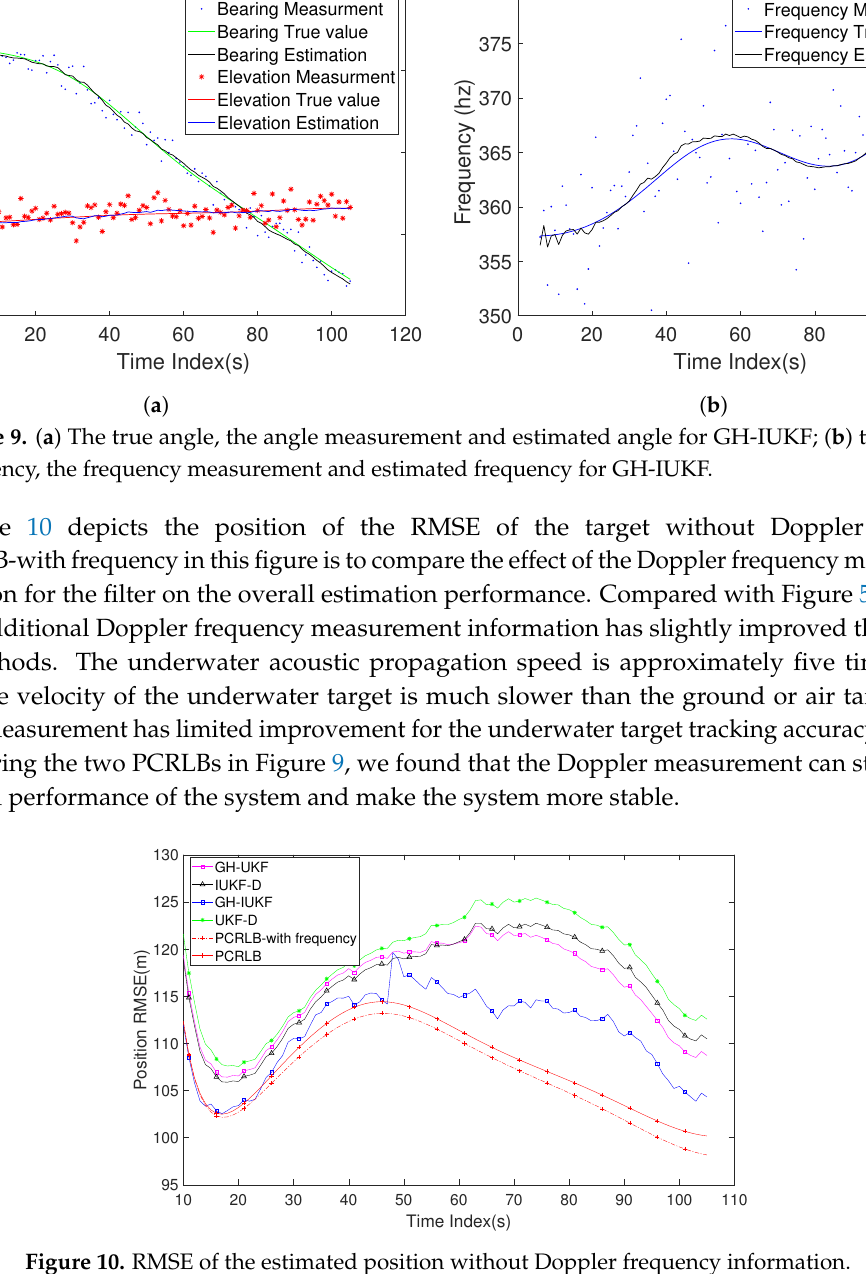
Figure 10. RMSE of the estimated position without Doppler frequency